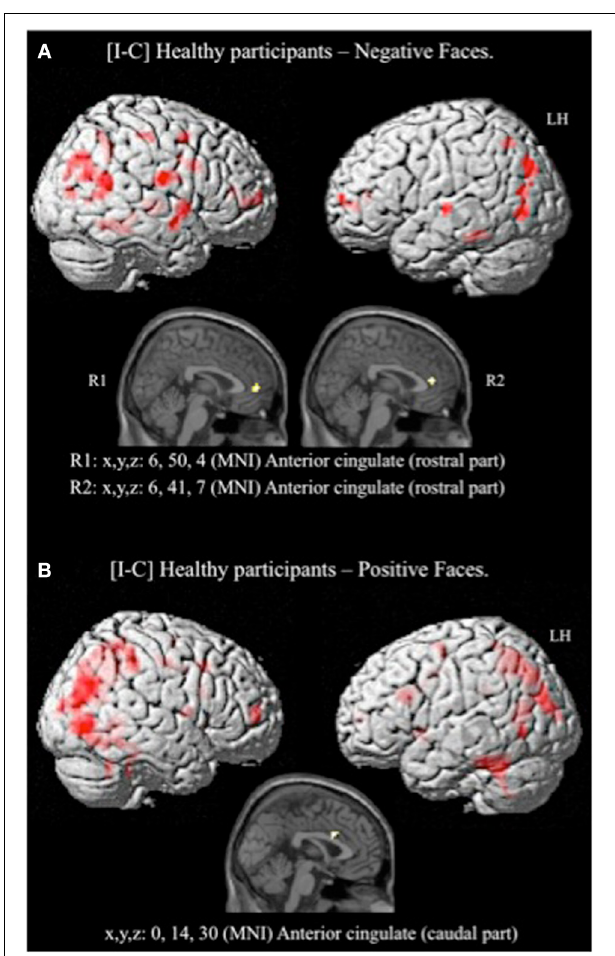
FIGURE 5 | Brain activation during the emotional Stroop task (contrast: Incongruent vs. Congruent) with separate analysis of negative (A) and positive (B) faces, in healthy subjects. p < 0 . 001, k > 5, n = 12, uncorrected. C, congruent; I, incongruent; LH, left hemisphere; MNI, Montreal Neurological Institute; R1, region 1; R2, region 2; x, y, z: mediolateral, rostrocaudal, and dorsoventral.